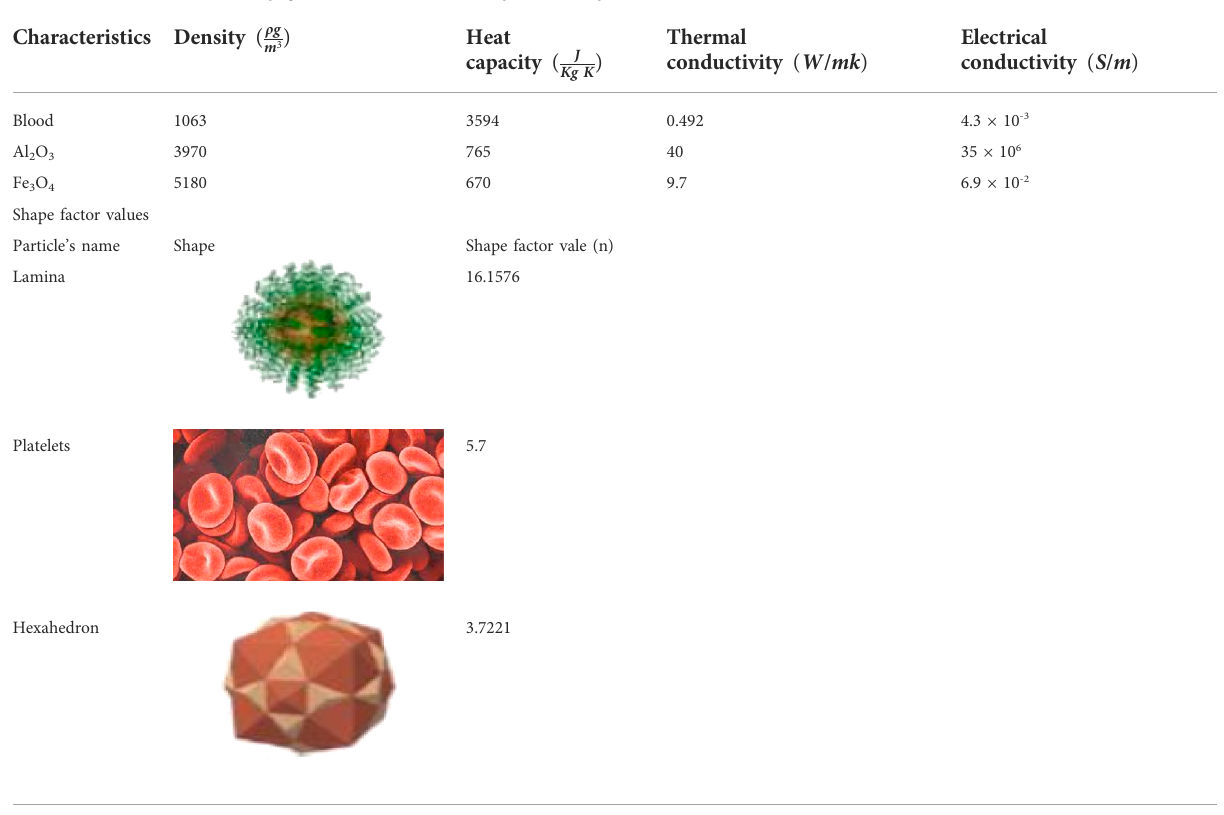
TABLE 1 The values for thermophysical attributes and nanoparticle shape